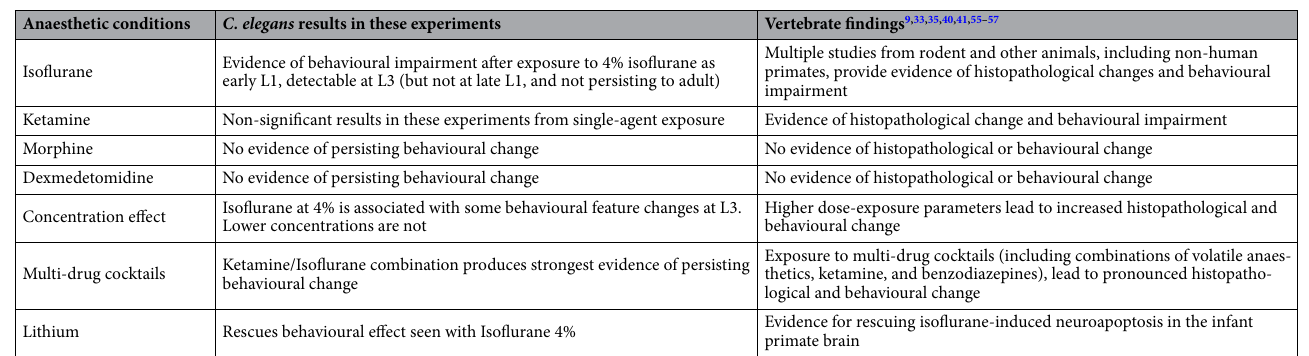
Table 1. Summary of evidence: anaesthetic exposure to C. elegans in these experiments, and previous literature from vertebrate experiments.